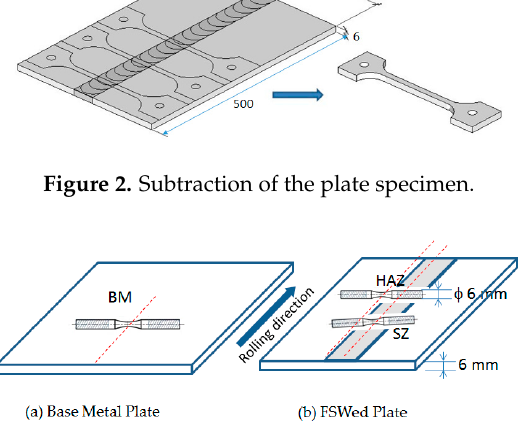
Figure 2. Subtraction of the plate specimen.